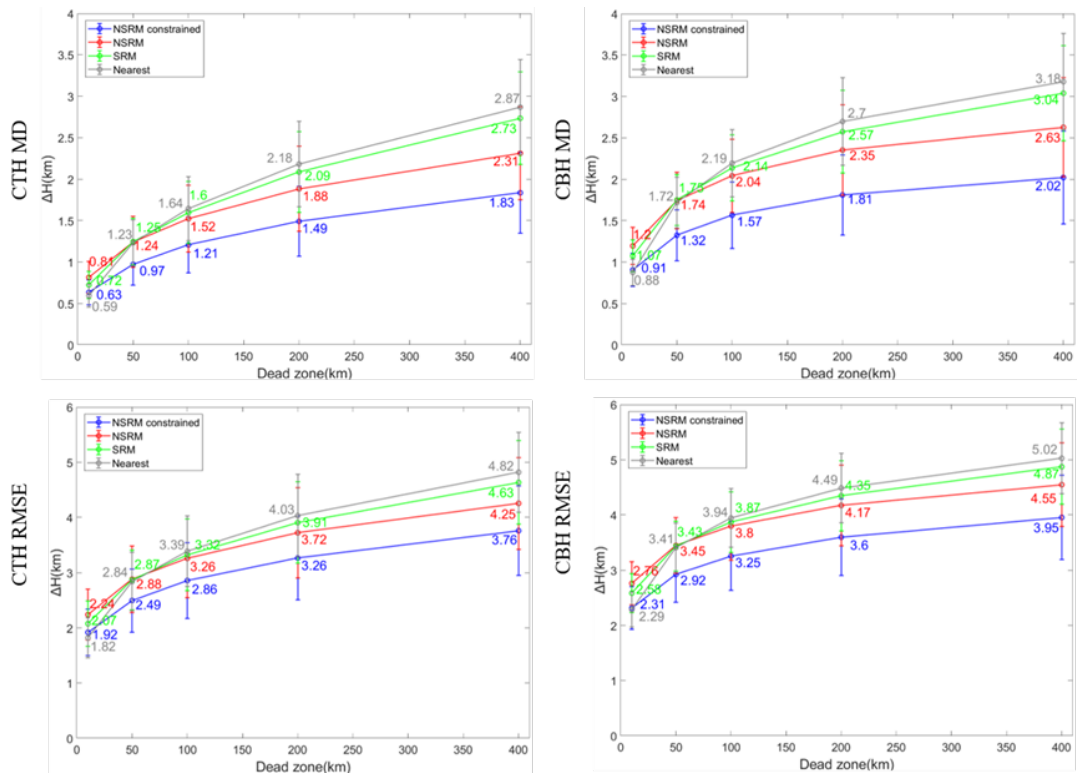
Figure 5. Comparison of MD of CTH and CBH between the original profiles and the reconstructed profiles. The profiles were reconstructed with the NSRM method ( α = 0.3 and β = 1.5), the similar radiance matching (SRM) method, and the direct selection of the nearest donor.